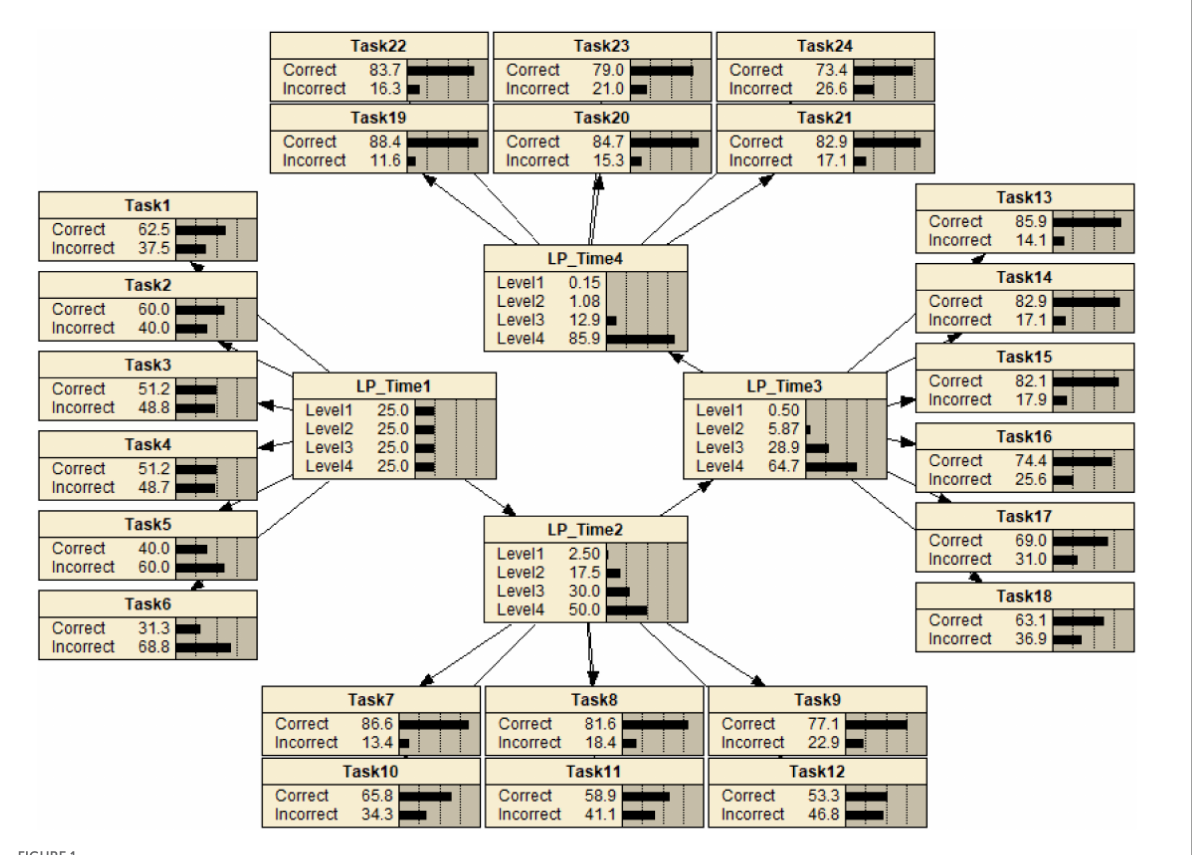
FIGURE1 An initial representation of DBN for modeling